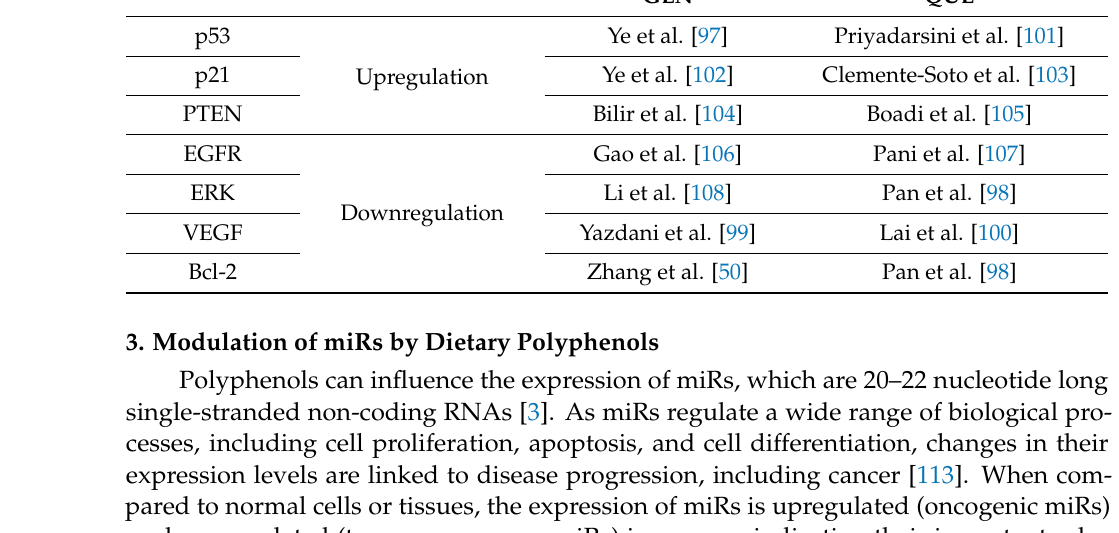
Table 3. Modulation by GEN and QUE of the molecules constituting the ROS-mediated anticancer pathway.